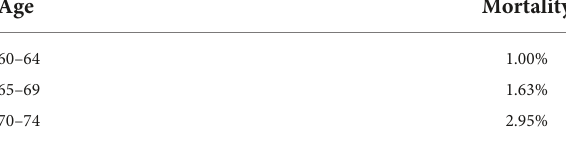
TABLE 1 Age-specific natural mortality rate (China Statistics Press,